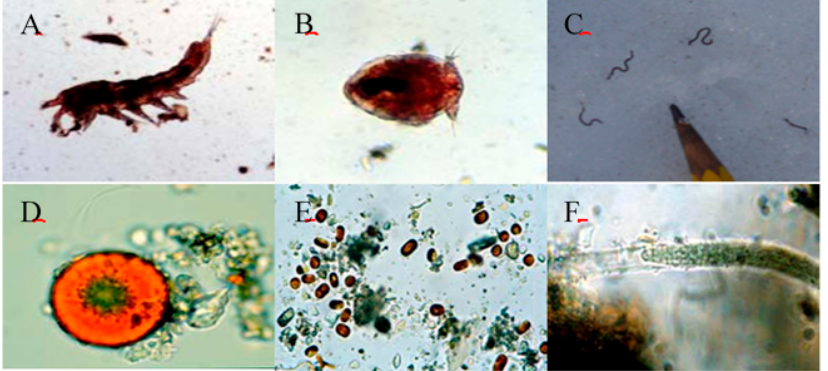
Figure 10. Microbial communites, including ( A ) copepods, ( B ) copepods, ( C ) worms, ( D ) green algae, ( E ) green algae and ( F ) blue bacteria in glacier dust pits.